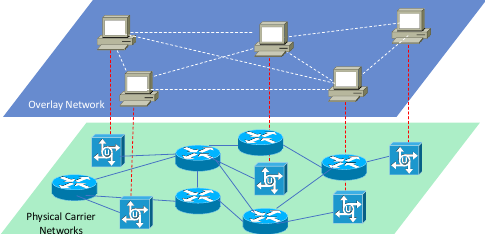
Figure 2. Overlay networks on top of physical carrier networks.